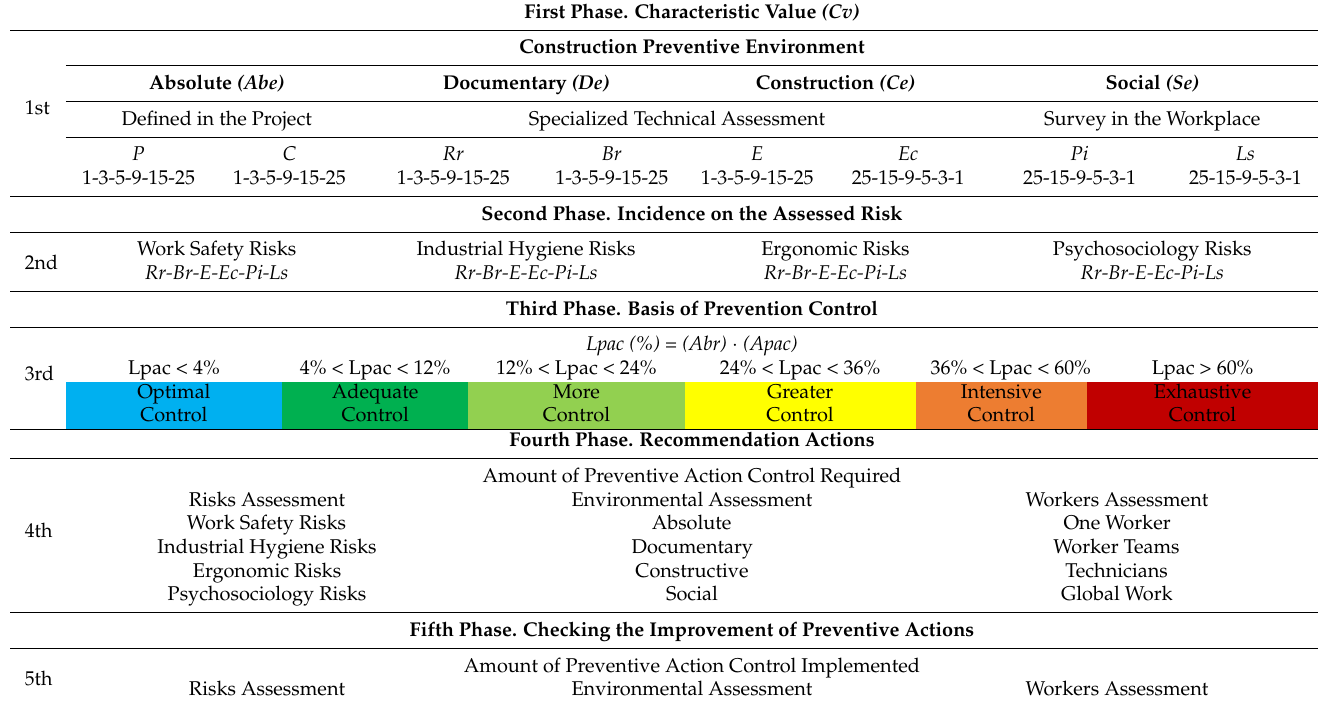
Table 2. Methodology Level of Preventive Action. Scheme of the